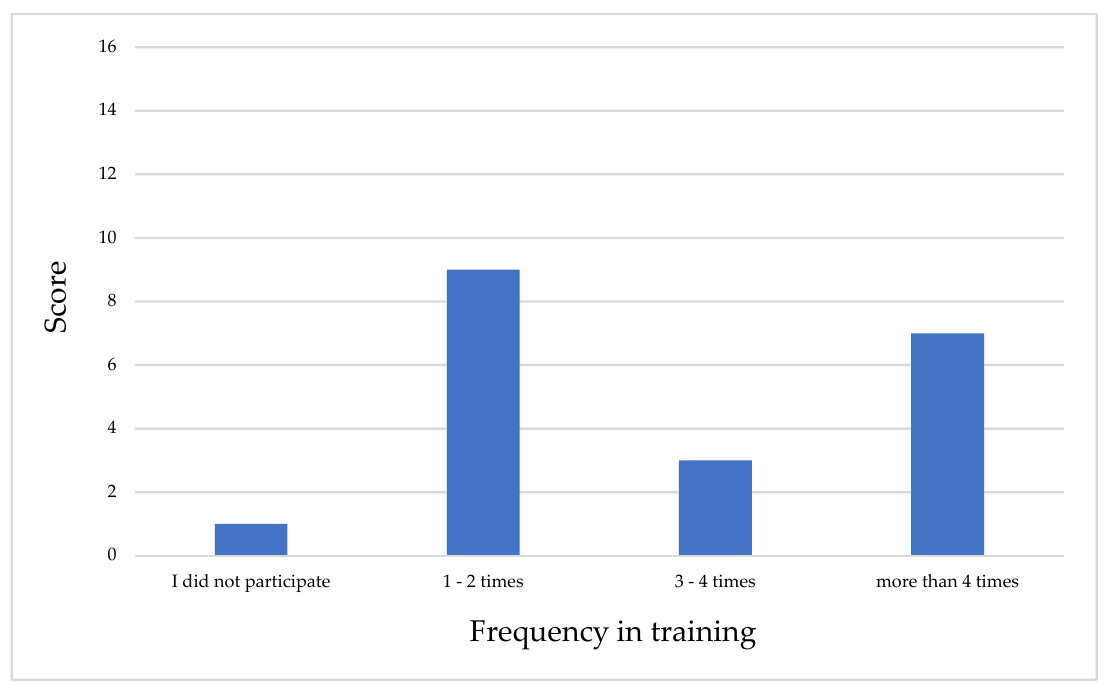
Figure 6. The frequency of participation in training courses in 2020–2021.